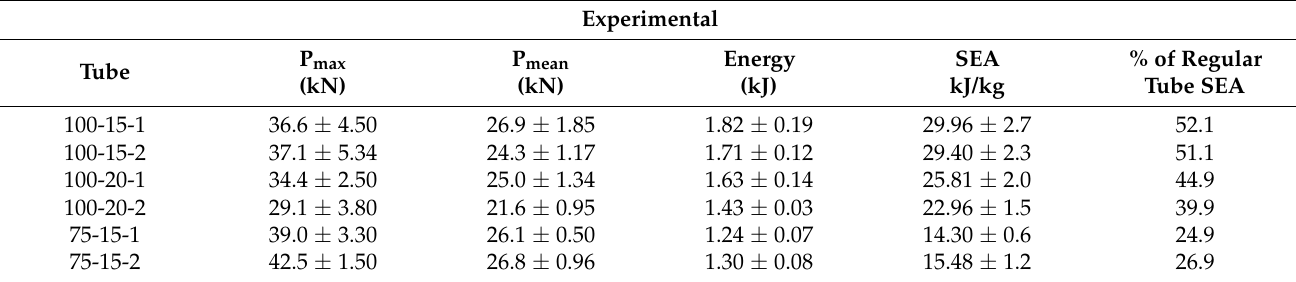
Table 4. SEA and other data for tubes with